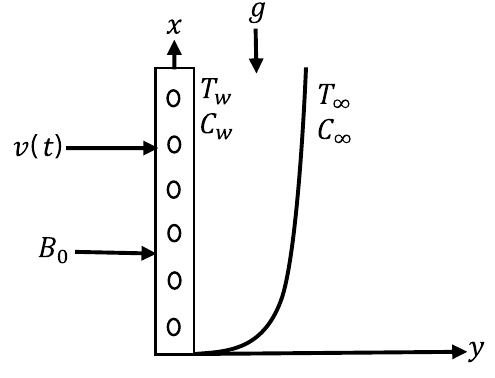
Fig. 1 Physical model and coordinate